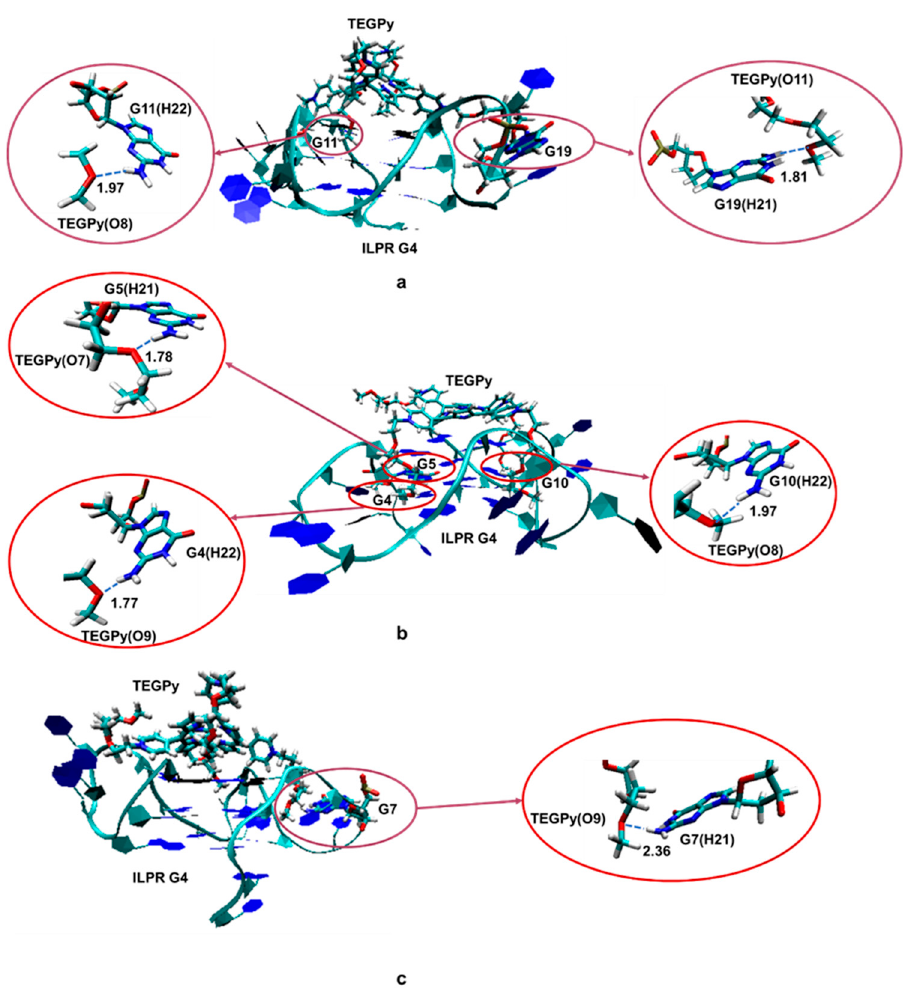
Figure 5. Schematic illustration of hydrogen bonds formed in the ILPR G4-TEGPy complex (see text for description of individual interactions ( a – c ). The guanine bases participating in the hydrogen bonding with TEGPy and TEGPy are represented as licorice, whereas the remaining part of ILPR G4 DNA is shown in new ribbon. All distances presented in this figure are labeled with dashed lines and given in Å. See Figure S5 for the numbering scheme of the O atoms.